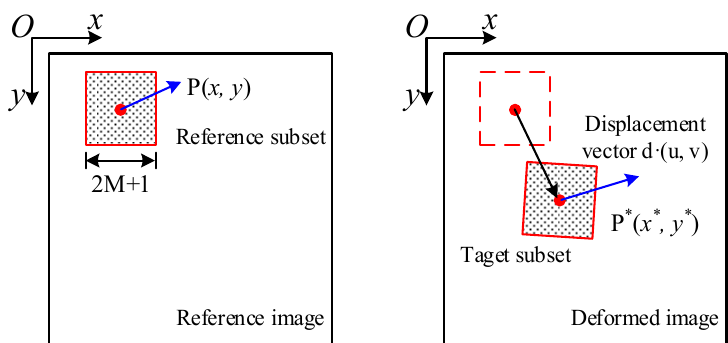
Figure 5. The principle of Digital Speckle Correlation Method (DSCM).